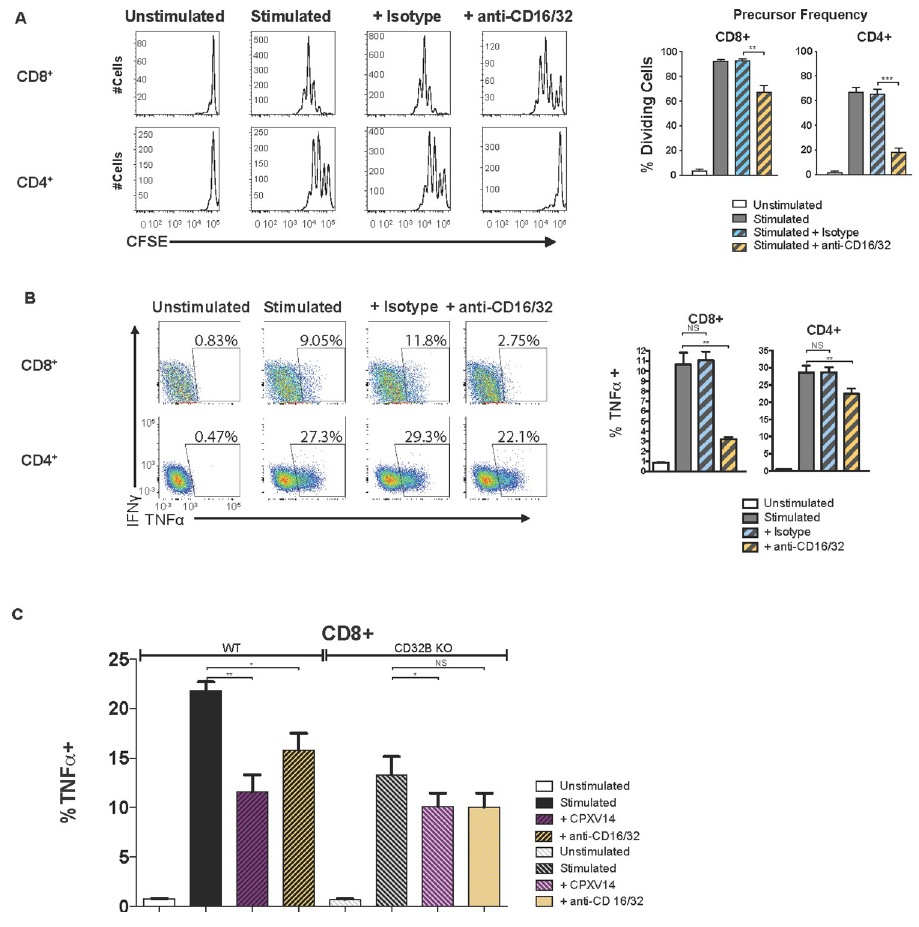
Fig 5. Inhibition of antibody-mediated T cell activation by CPXV14 depends on Fc γ -receptors on auxiliary cells and can be recapitulated with Fc γ R-targeting antibodies. A) Fc γ R antibodies inhibit proliferation of na ï ve T cells similar to CPXV14. Splenocytes from BALB/cByJ mice, unenriched or enriched for CD3+ cells ( > 98%), were loaded with CFSE and stimulated with α -CD3 and recombinant murine IL-2 for 3 days in the presence or absence of 200nM α -mCD16 and α -mCD32 followed by flow cytometry. Representative histograms for CD8+ and CD4+ T cells collected from one animal (left) or average percentage (+SEM) of dividing cells from 5 mice (right) are shown. B) Fc γ R antibodies inhibit activation of na ï ve T cells similar to CPXV14. Splenocytes from BALB/cByJ mice, unenriched or enriched for CD3+ cells, were incubated with 20nM α -mCD16/32 where indicated for 4h prior to ICS. Representative dot plots are shown on the left and the average TNF α + response frequencies of T cells from 5 mice (+SEM) is shown on the right. C) Inhibition of antibody-mediated na ï ve T cell activation by CPXV14 is dependent on the low affinity Fc γ RIIB (CD32B). Splenocytes from three CD32B KO mice and three B6129SF2/J control mice were incubated with 100nM of CPXV14-His or the α -mCD16/32 where indicated for 4h prior to ICS. The average frequencies of TNF α + CD8+ T cells (+SEM) are shown. P-values were calculated using unpaired two-tailed Student’s T test ( ��� p � 0.001, �� p � 0.01, � p � 0.05, NS = p >